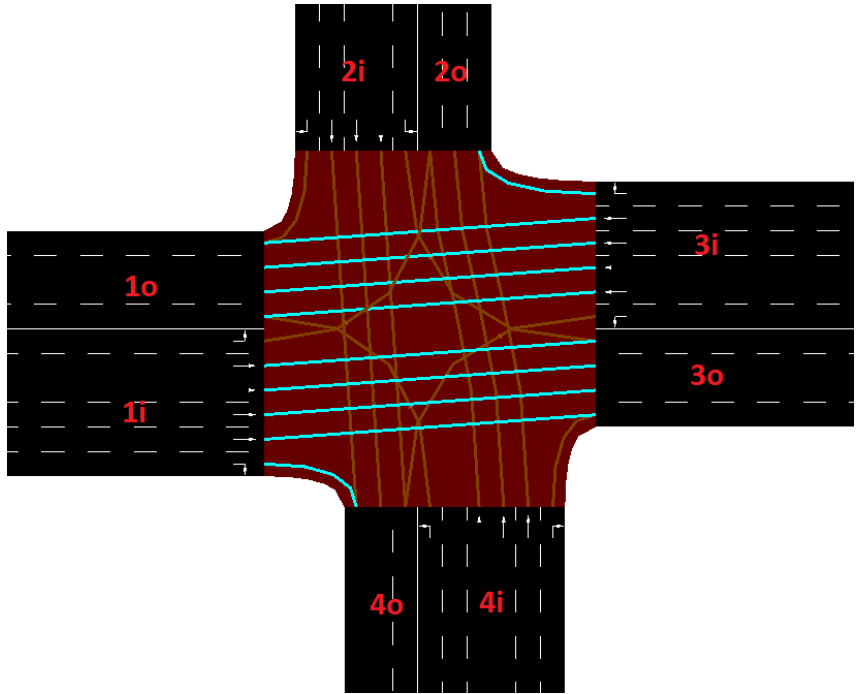
Figure 3. Label assignments for network edges